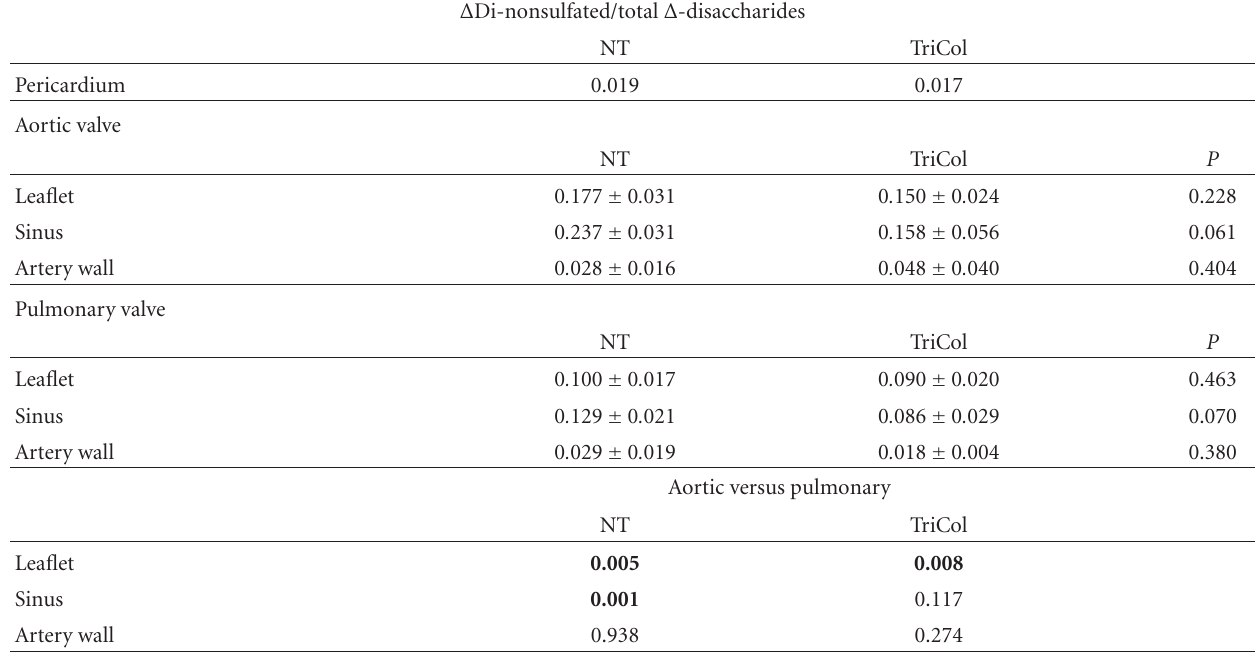
Table 2: Percentages of nonsulfated disaccharides from CS isomers in the examined tissues (means ± SD). Significant di ff erences ( P < 0 . 05) are reported in bold.